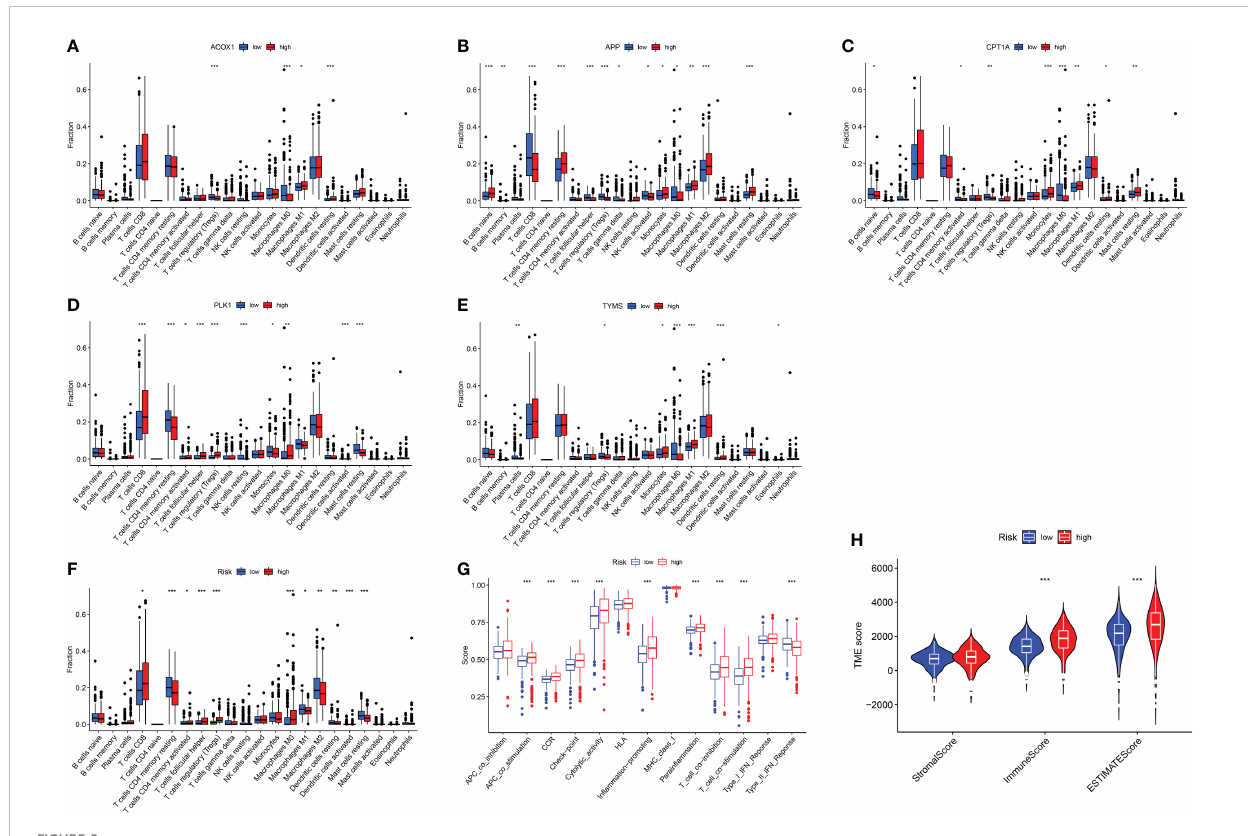
FIGURE 8 Immune response of target genes for KIRC patients. (A – F) Boxplot of target gene signatures associated with 22 immune cell in fi ltration. (G) The analysis of immunological functions. (H) the tumor microenvironment score. * p < 0.05, ** p < 0.01, *** p < 0.005.